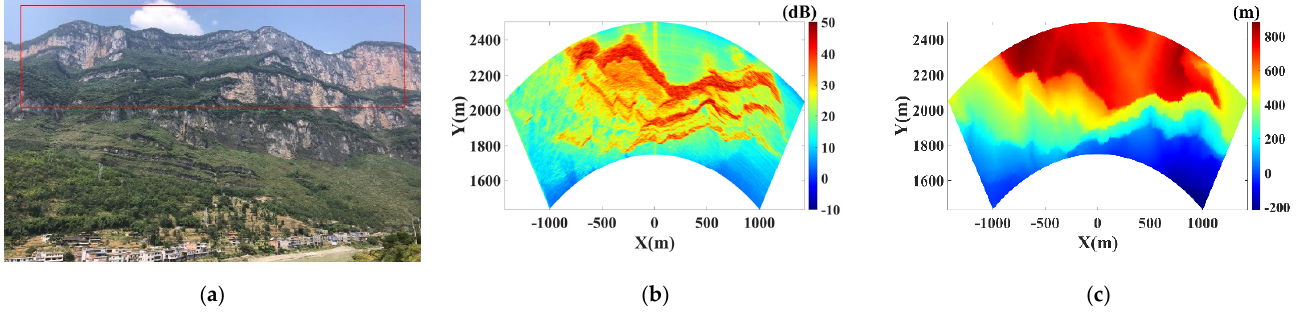
Figure 13. Experimental scenario: ( a ) Photo; ( b ) SNR map; ( c ) Elevations in radar coordinates.